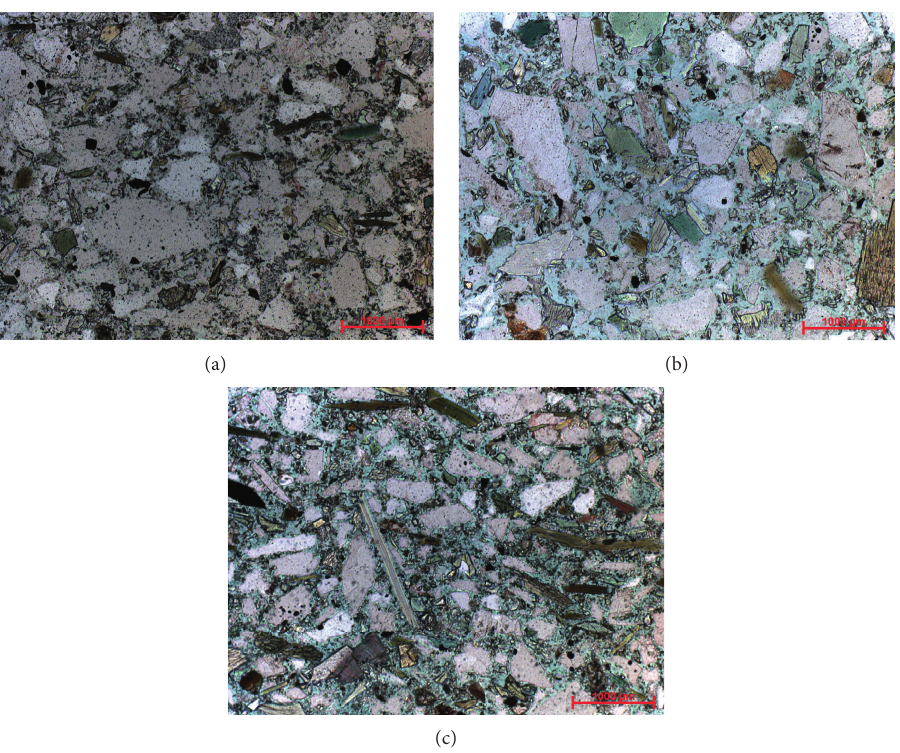
Figure 10: The cast thin slices in different positions of specimen no. 9. (a) C-10-d-above slice image (b) C-10-d-middle slice image. (c) C-10- d-below slice